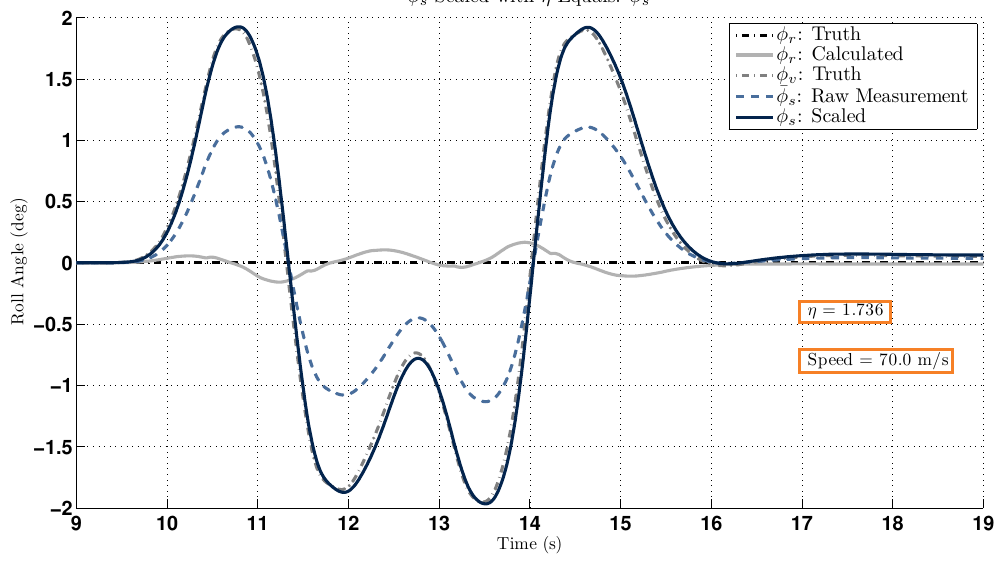
Figure 2. Simulated vehicle performing a double-lane change (DLC) maneuver on a flat